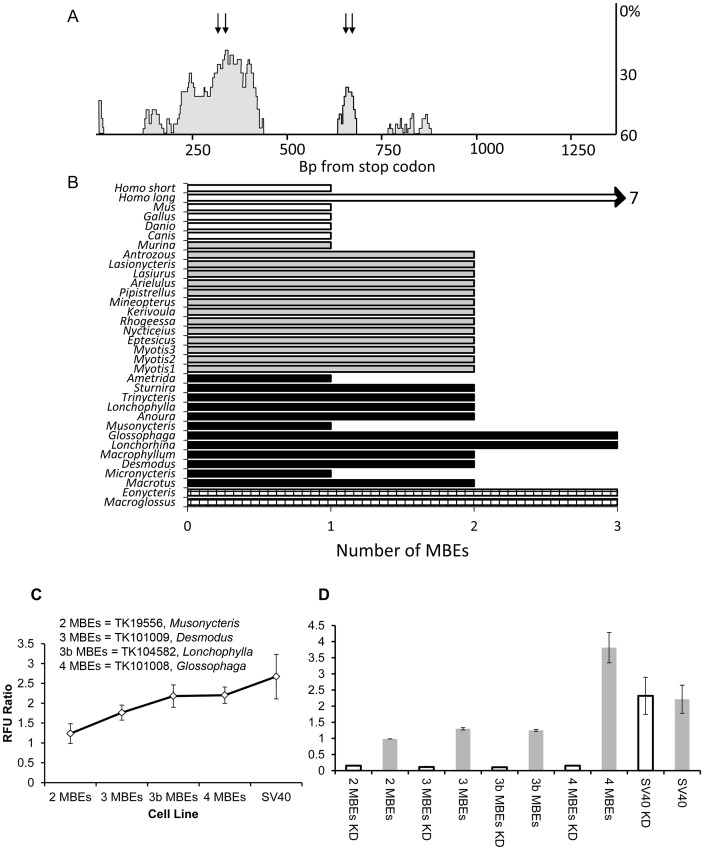
Comparative genetic and post-transcriptional reporter analysis.A) Patterns of nucleotide conservation across the 3′ UTR of PAX9 based on an alignment of Homo, Canis, Mus, and all bat species of this study, in which the vertical axis represents sequence divergence and the horizontal axis represents base pairs from the stop codon. Conserved domains are represented by grey areas and the locations of MBEs are demarked with arrows. The location of all seven MBEs occurring in a human alternative transcript are not show to conserve space (length >3Kb). B) Histogram summarizing the frequency of MBEs across taxa surveyed (checkered = pteropodids, black = phyllostomids, grey = vespertilionids, and white = non-bat taxa). Homo long and Homo short refer to the two alternative transcripts of PAX9 observed in humans. C) Results of the fluorescent reporter assay, with error bars representing standard mean error. Cell lines labeled as ‘3 MBEs’ and ‘3b MBEs’ are alternative spatial combination of this motif frequency and, SV40 represents the construct with only SV40 polyadenylation signal containing no MBE. D) Result of the knockdown assay. Cell lines denoted with KD indicate knockdown lines. Error bars represent standard mean error, and are not visible in some instances due to the error being within histogram bar thickness.